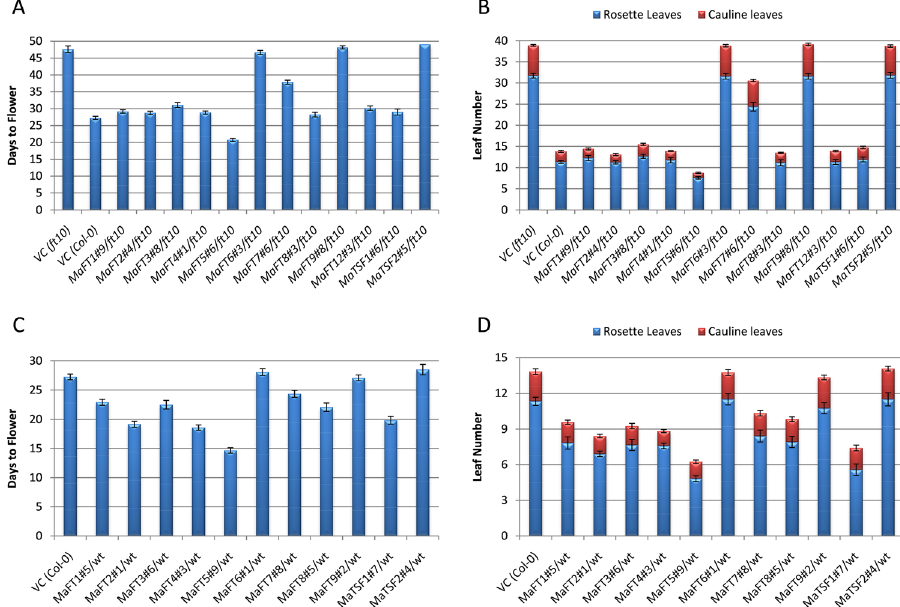
Figure 9. Expression of the banana FT / TSF -like genes in the ft - 10 and Col-0 background of Arabidopsis . Various banana FT / TSF -like genes were expressed under the CaMV35S promoter in the ft - 10 mutant background ( A and B ) and the Col-0 background ( C and D ) of Arabidopsis. Days to flower ( A , C ) were counted as number of days taken to bolt under long day conditions (16 h light, 8 h dark). Leaf number ( B , D ) was calculated by combining total rosette leaves and cauline leaves on primary inflorescence. For each line, a minimum of 12 plants were selected and data shown is average of independent lines ± SE for each gene.